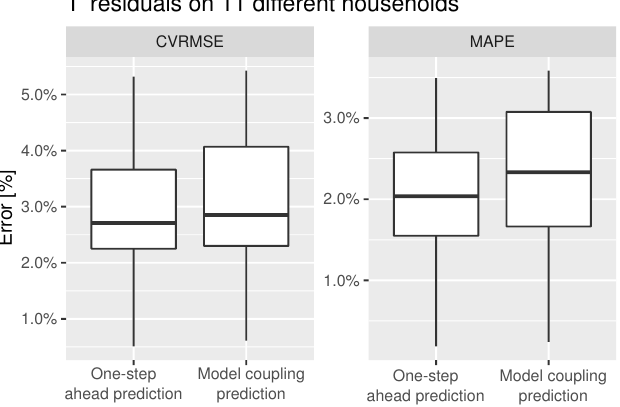
Figure 13. Hourly indoor temperature CVRMSE and MAPE of 11